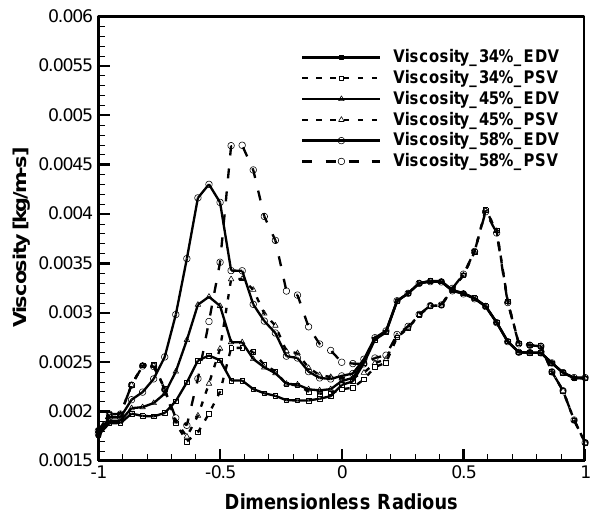
Figure 7. Viscosity distribution at Line (E), anastomosis angle is 45 ◦ . Figure 8 is the contour of the X-Y plane for the velocity w component at the Line